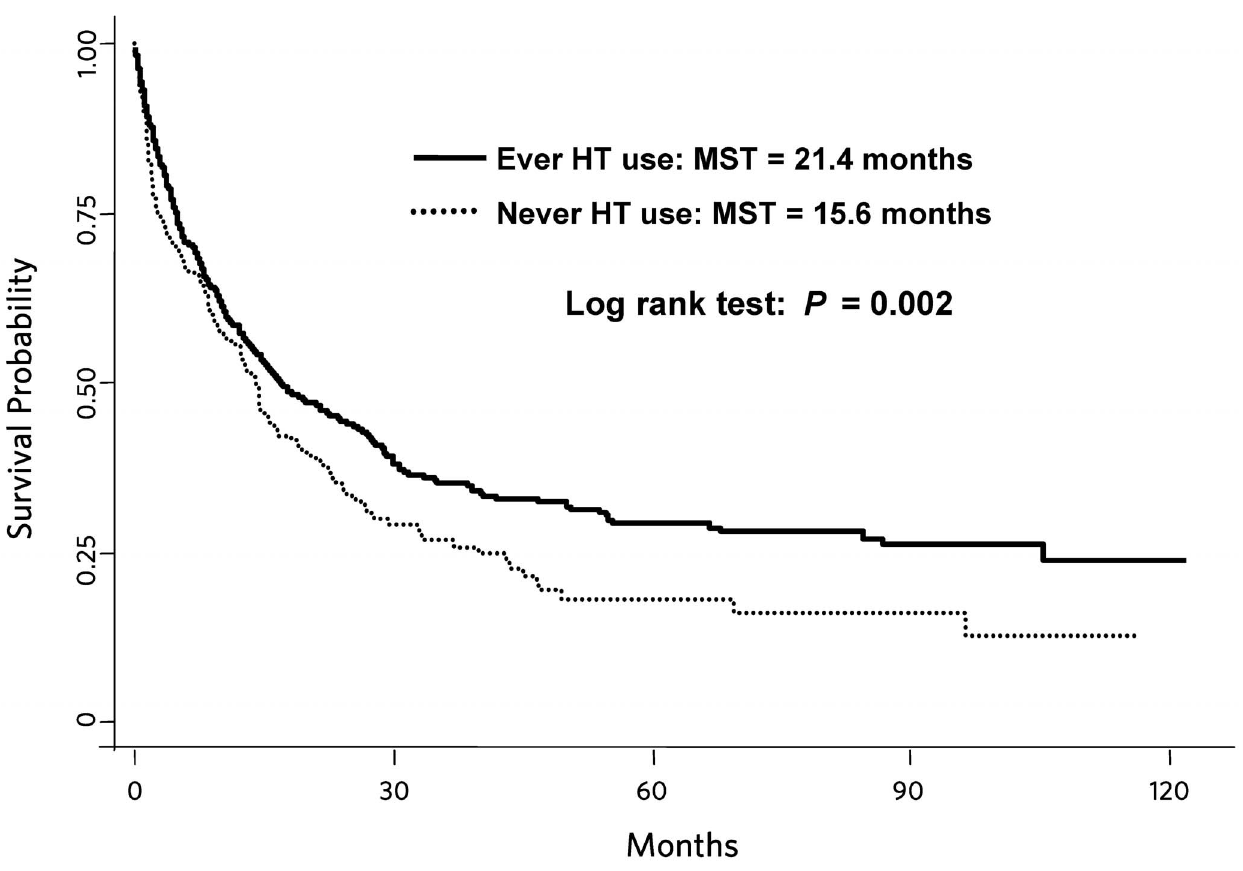
Figure 1. Kaplan-Meier curves of lung cancer-specific survival by ever and never MHT use. Ever MHT use: n=297 deaths/511 cases; Never MHT use: 144 deaths/216 cases. MST=median survival time.